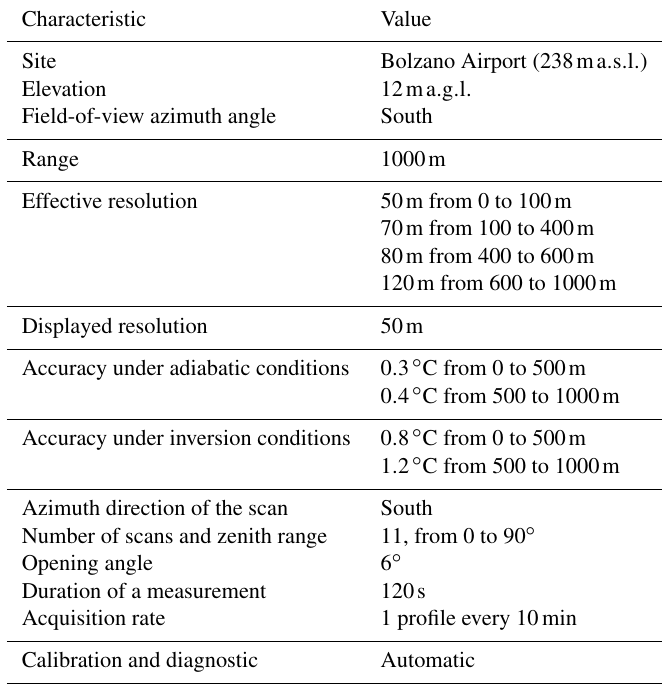
Table 2. Technical characteristics of the microwave temperature profiler (MTP-5HE) installed at the airfield of